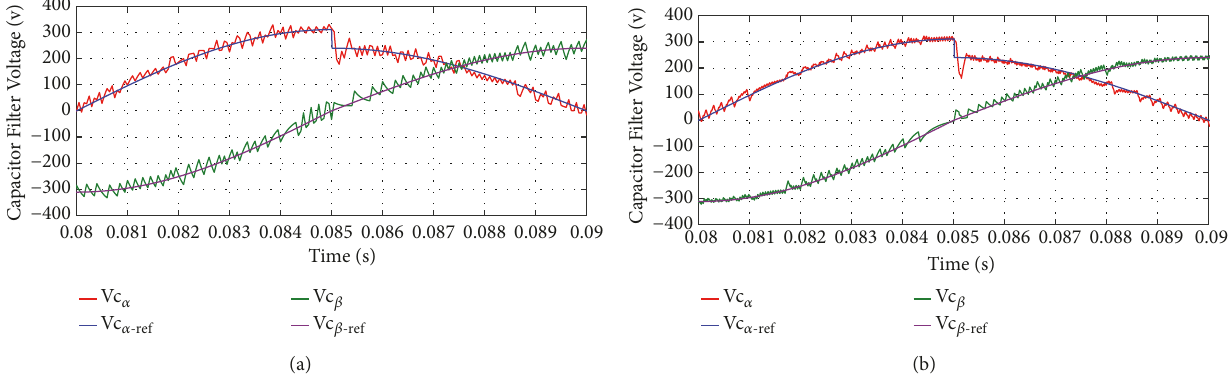
Figure 11: Results of capacitor filter voltage for a step in the amplitude of 𝑉𝑐 𝛼 𝑟𝑒𝑓 and 𝑉𝑐 𝛽 𝑟𝑒𝑓 . (a) The conventional MPVC. (b) The proposed